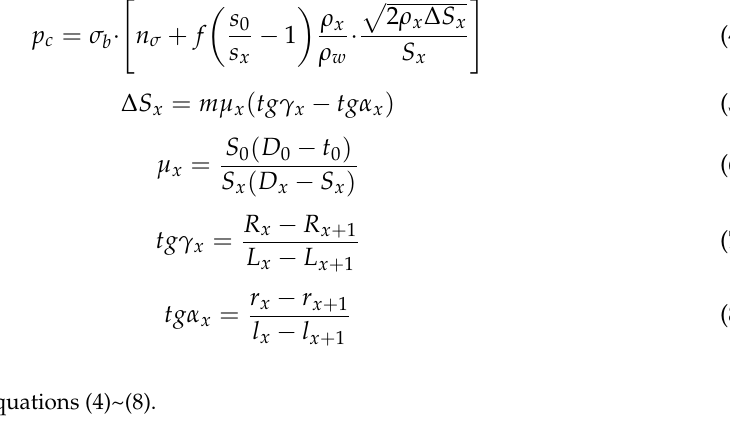
p c The normal pressure per unit area of the roll (mandrel) on the pipe σ b strength of the mother pipe under different deformations n σ coefficient of principal stress coefficient of friction between roller(mandrel) and pipe The normal pressure per unit area of the roll (mandrel) on the pipe S 0 the wall thickness of the mother pipe S x pipe wall thickness at position x S x the instantaneous reduction in wall thickness at position x x roll groove radius at position x w the radius of the drive gear pitch µ x rolling elongation coefficient of pipe at x γ x taper between any x and x + 1 positions at the ridge of the roll groove the instantaneous reduction in wall thickness at position x α x taper between any x and x + 1 positions at the ridge of the mandrel R x groove radius at any x position of the roll groove x r x radius at any x position of the mandrel w D 0 The outer diameter of the mother pipe rolling elongation coefficient of pipe at x D x pipe outer diameter at position x taper between any x and x + 1 positions at the ridge of the roll L x distance between any x and x + 1 positions at the ridge of the roll groove groove l x distance between any x and x + 1 positions at the